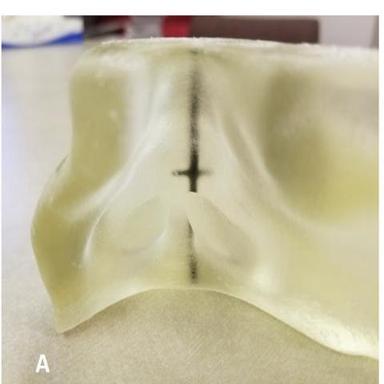
Examples of 3D bolus used to treat a skin malignancy involving the nose (A) and lip (B) are shown. The black cross provides built-in daily setup localization at the treatment isocenter for use with an in-room laser alignment system. This mark has been printed into the bolus and aids in rapid, reproducible bolus placement. Panel B demonstrates the excellent bolus clarity.